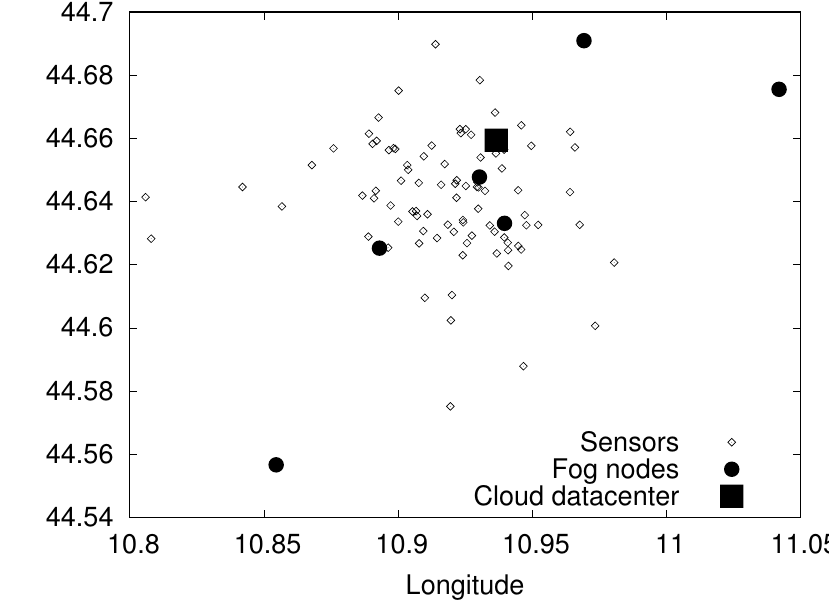
Figure 4. Smart city